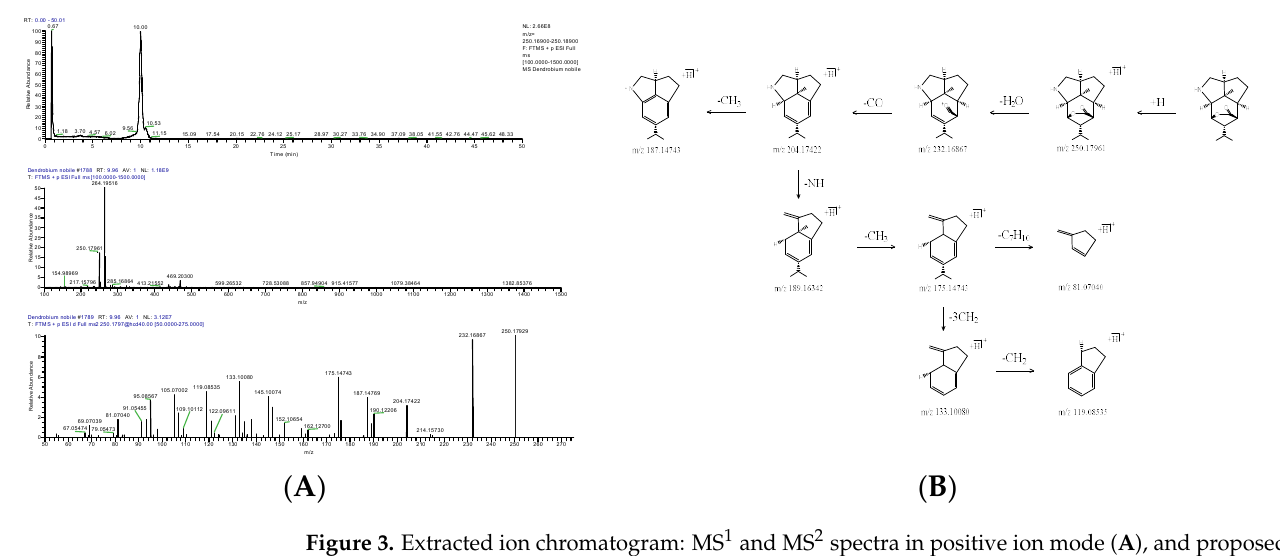
Figure 3. Extracted ion chromatogram: MS 1 and MS 2 spectra in positive ion mode ( A ), and proposed main fragments of nordendrobin (DN 11) ( B ).